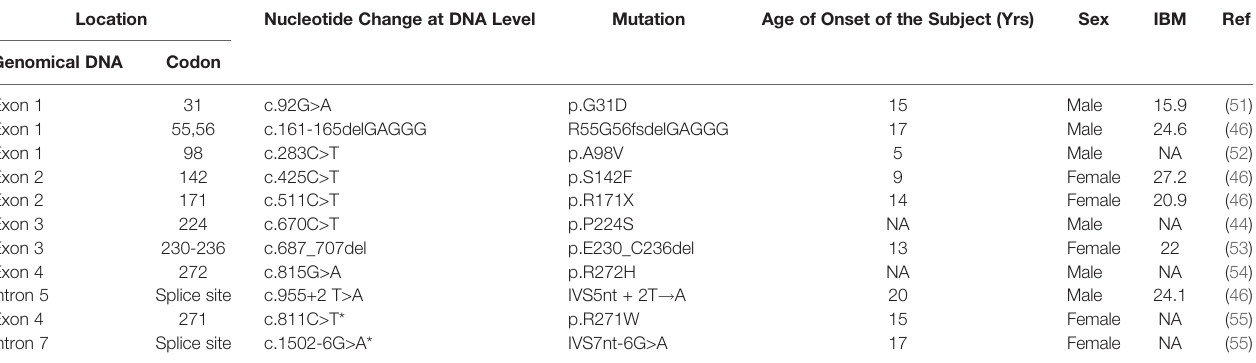
TABLE 3 | The HNF1A SNPs associated